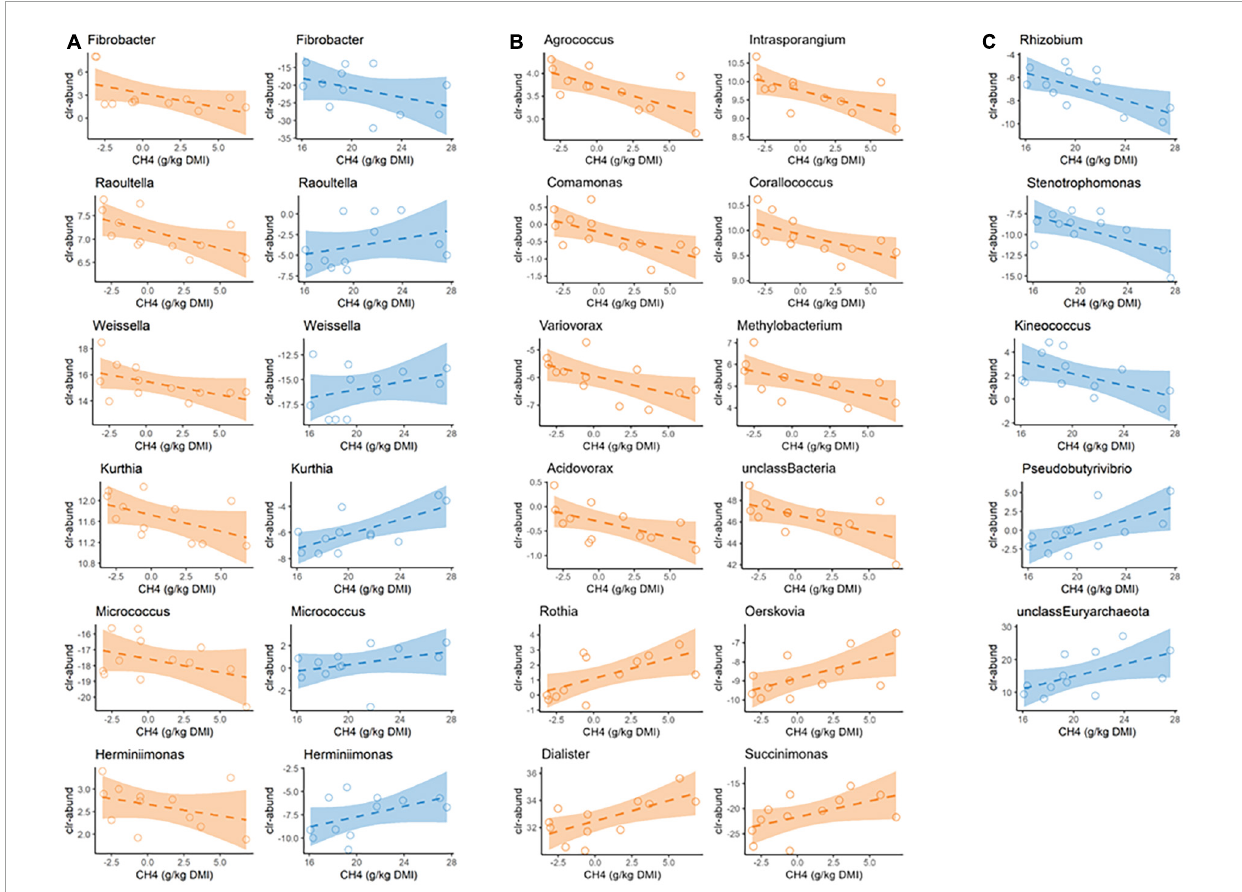
FIGURE4 Visualization of linear associations between clr -transformed abundances of microbial genera identified with PLS analysis and methane yield in fresh cut grass (Grass, in blue) or high concentrate (TMR, in orange) fed animals. Full details of the analysis can be found in Supplementary Table 2 . (A) Six microbial genera were selected in the PLS model in both diet groups, although only Fibrobacter was associated with methane yield in the same direction. (B,C) Microbial genera presenting a linear regression coefficient with a probability of being different from 0 ≤ 0.95 on methane yield only under TMR (B) or grass (C)